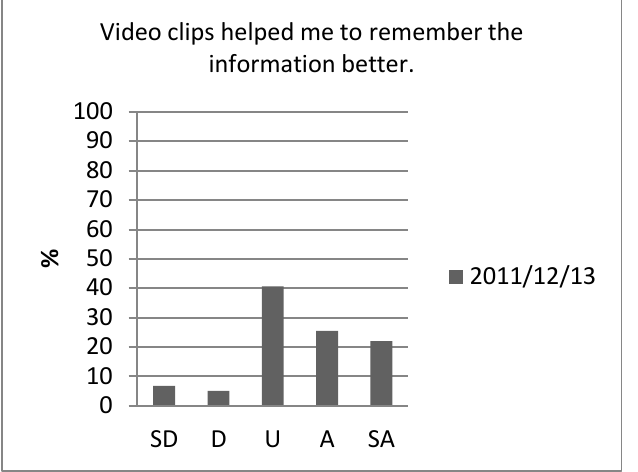
Figure 2. Responses on uncertainty regarding the value of video clips (Table 3, Item